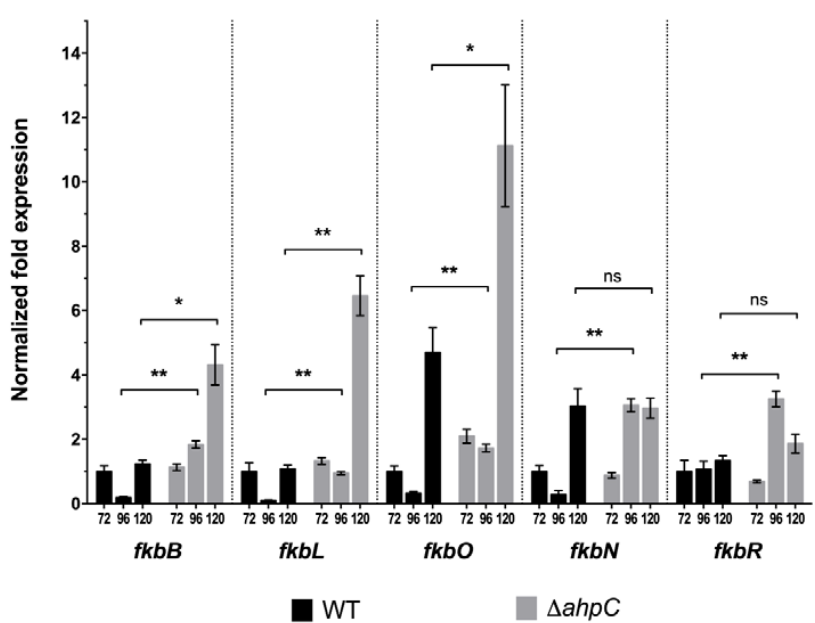
Figure 3. Gene expression analysis of selected genes of the tacrolimus biosynthetic gene cluster in S. tsukubaensis wild type (black bars) and ∆ a hpC strain (grey bars) grown in MGm-2.5 medium. The mean normalized fold expression ( ± standard errors) of genes fkbB , fkbL , fkbO , fkbN and fkbR at 72 h, 96 h and 120 h of growth was calculated relative to the transcription of the reference genes ( STSU_08694 and hrdB –M value 0.4432) and the reaction of internal normalization was performed using the wild type at 72h as the control situation. Statistically significant differences: * p < 0.05; ** p < 0.01; ns—not significant.